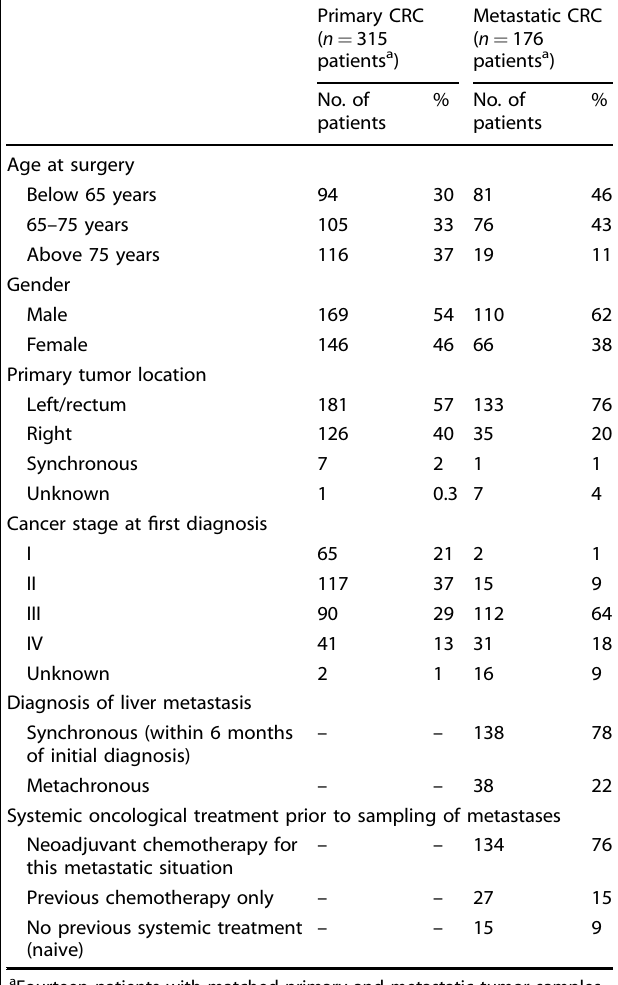
Table 1. Clinicopathological